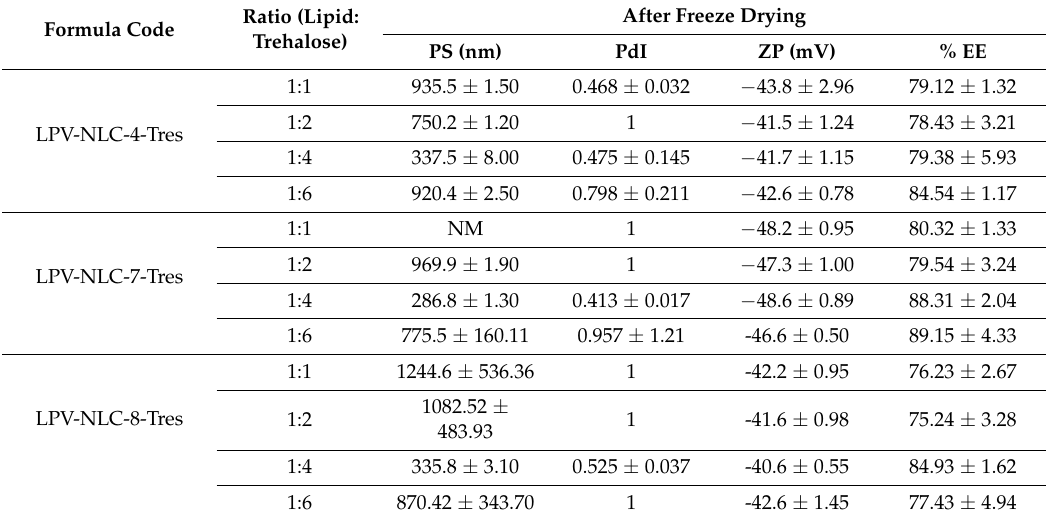
Table 6. Influence of cryoprotectant addition during homogenization process on PS, PdI, ZP and